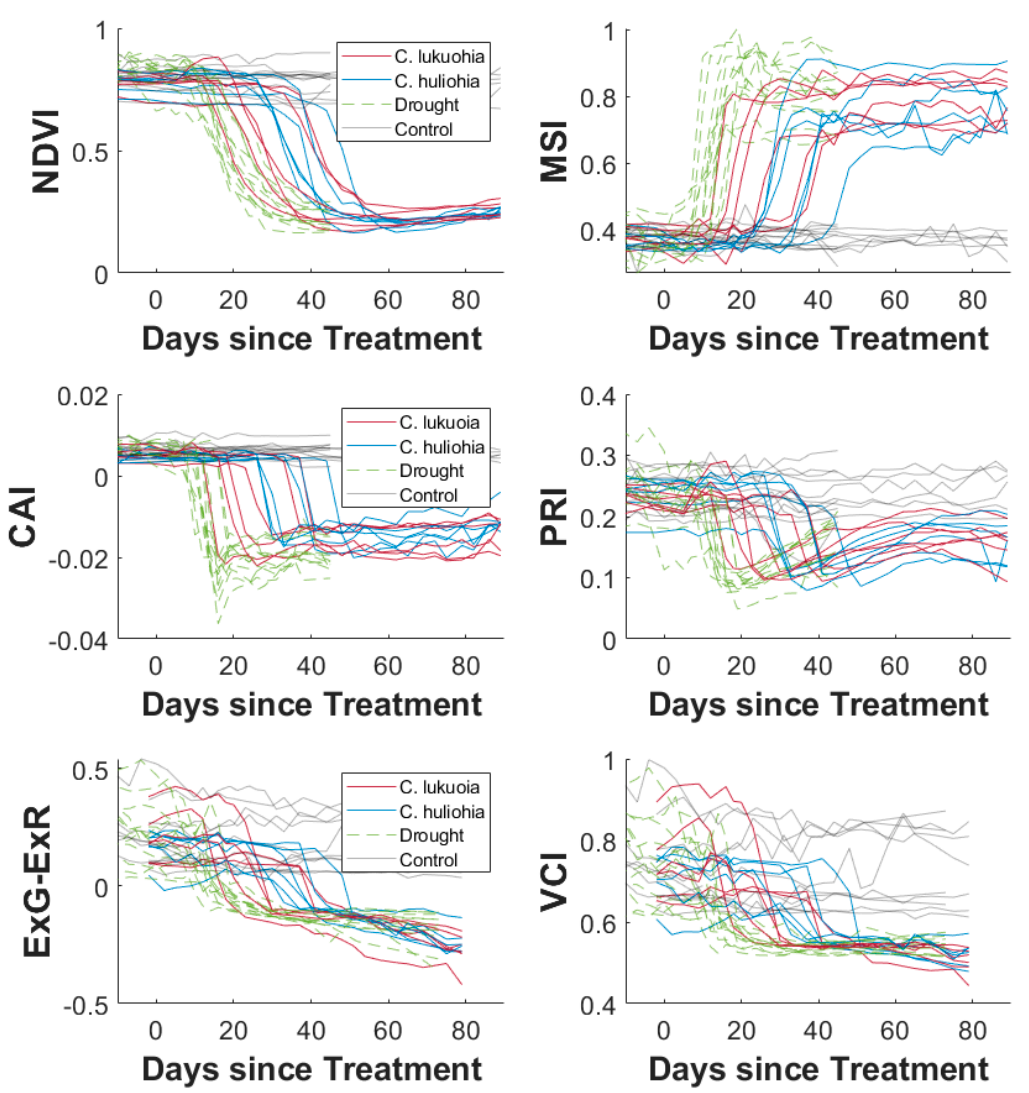
Figure 7. Time series of Vegetation Index (VI) curves for all plants involved in the laboratory trials. ExG-ExR and vegetation contrast index (VCI) VIs were derived from RGB photos, all other VIs were derived from spectroradiometer data.